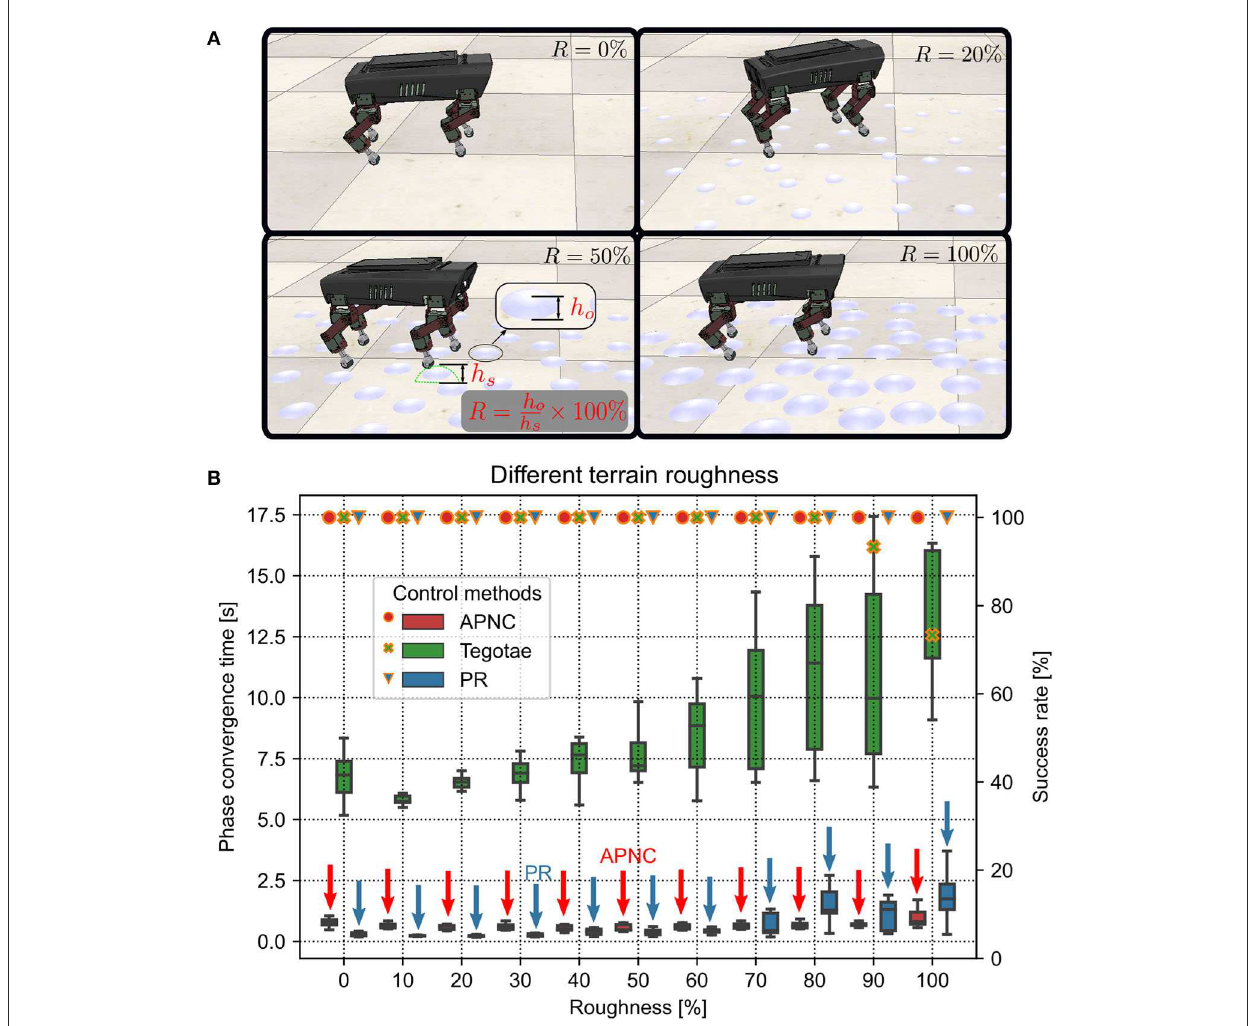
FIGURE6 (A) Illustrations of four uneven terrain examples with different roughness ( R ) (0 % , 20 % , 50 % , and 100 % ). The robot walking behavior related to the different terrain roughness conditions can be viewed at http://www.manoonpong.com/AdaptiveCommunications/video2.mp4. (B) Phase convergence time (represented by the boxes along with the left axis) and success rate (represented by marks along with the right axis) of the robot performing self-organized locomotion under the three different control methods (APNC, Tegotae, and PR) and various terrain roughness conditions from flat ( R = 0%) to extremely rough terrains ( R > 60 % ). The success rate was defined as the ratio of successful phase convergences to total trials (i.e., 20). Red and blue arrows indicate the APNC and PR. Note that the phase convergence time, indicating the efficiency of a controller enabling the robot to achieve self-organized locomotion, is used here as a measure to assess how fast a control system can learn or adapt. However, other measures, like speed and balance, can be also used to evaluate the robustness of rough terrain